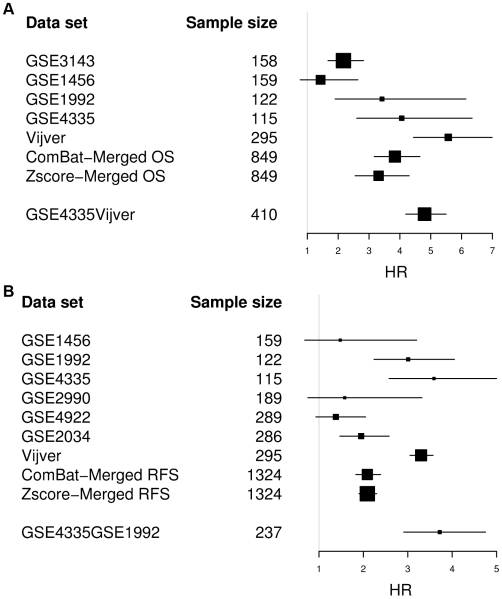
HR of the gene signatures derived from the merged and single breast cancer data sets.
Figure 6A: GSE3143: HR = 2.17, CI = 1.67–2.82, GSE1456: HR = 1.43 CI = 0.77–2.64, GSE1992: HR = 3.42 CI = 1.90–6.14, GSE4335: HR = 4.06 CI = 2.60–6.34, Vijver: HR = 5.57 CI = 4.44–6.99, ComBat-merged OS: HR = 3.84, CI = 3.17–4.65, Zscore-merged OS: HR = 3.31, CI = 2.55–4.30, GSE4335Vijver: HR = 4.80, CI = 4.19–5.50. Figure 6B: GSE1456: HR = 1.48, CI = 0.68–3.20, GSE1992: HR = 3.01, CI = 2.24–4.05, GSE4335: HR = 3.59, CI = 2.58–5.00, GSE2990: HR = 1.58, CI = 0.75–3.32, GSE4922: HR = 1.38, CI = 0.93–2.05, GSE2034: HR = 1.95, CI = 1.47–2.58, Vijver: HR = 3.30, CI = 3.05–3.57, ComBat-merged RFS: HR = 2.09, CI = 1.83–2.39, Zscore-merged RFS: HR = 2.09, CI = 1.83–2.39, GSE4335GSE1992: HR = 3.72, CI = 2.91–4.75.